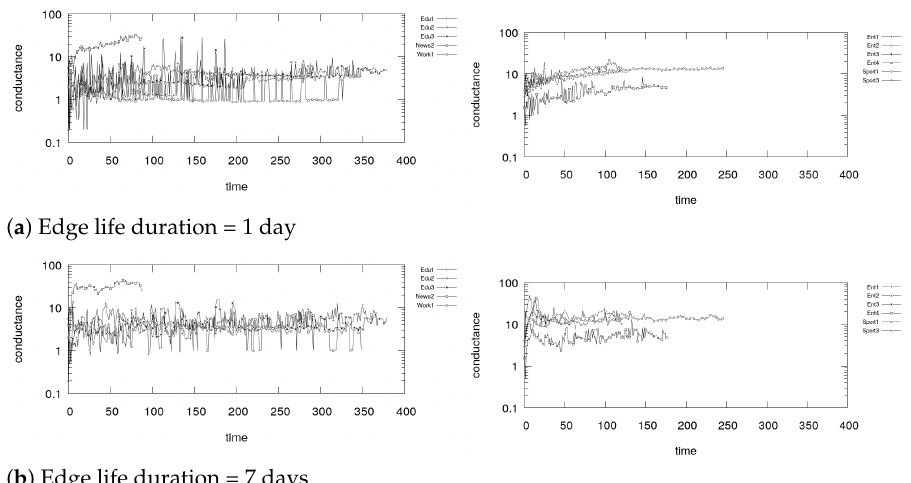
Figure 28. Conductance of communities detected by